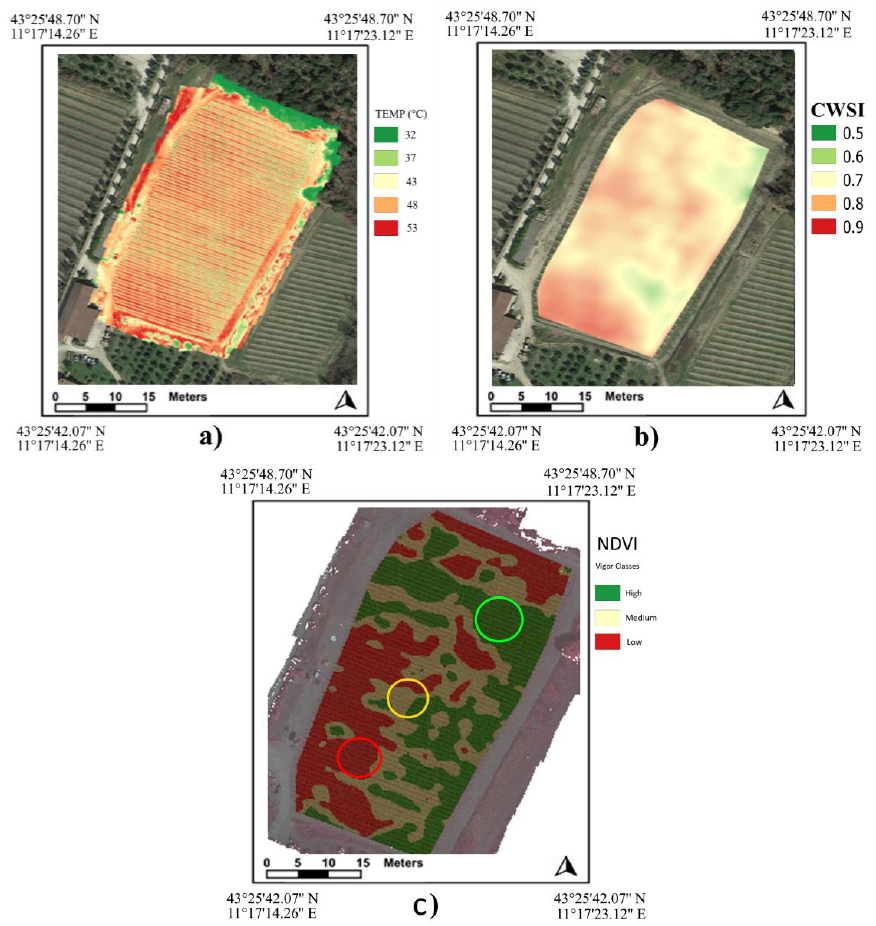
Figure 3. ( a ) Temperature (TEMP), ( b ) Crop Water Stress Index (CWSI) and ( c ) normalized difference vegetation index (NDVI) vigor maps from data acquired at Site